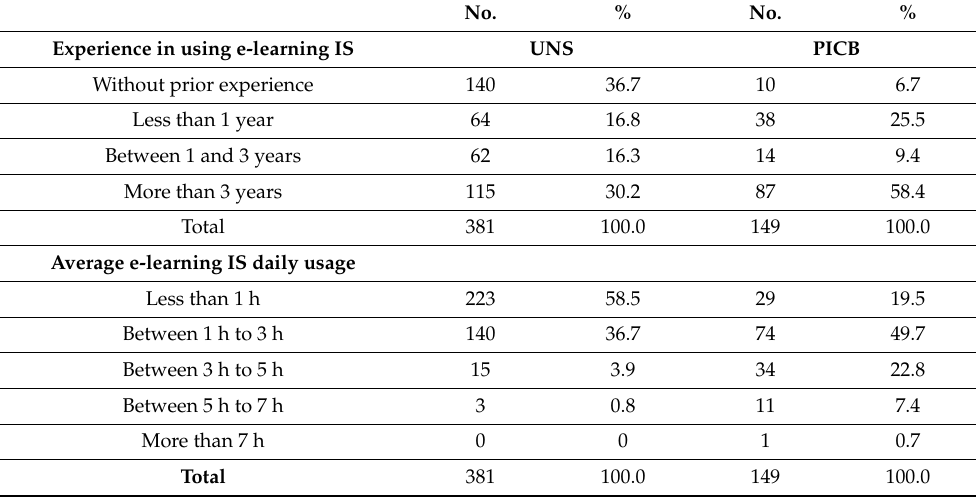
Table 3. Sample structure according to experience in using IS and average daily usage.